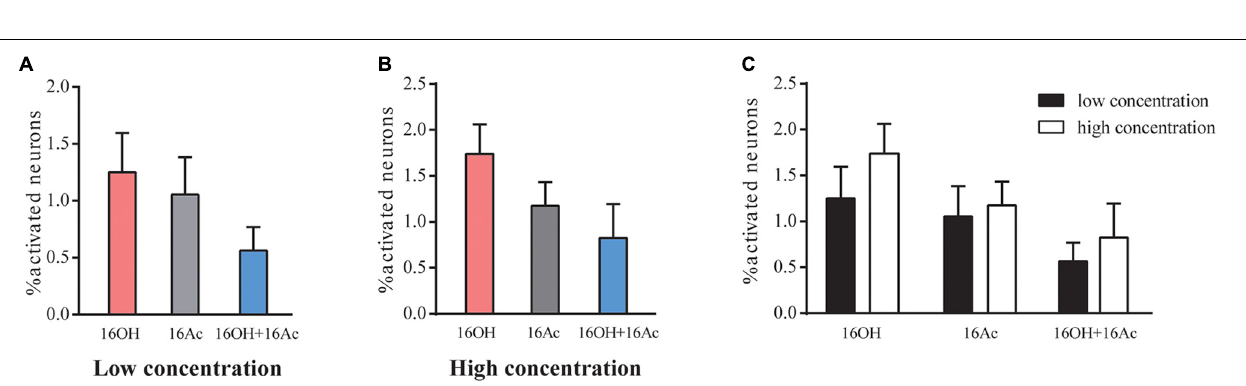
FIGURE 2 | Male VSNs respond similarly to 16OH and 16OHAc at both low and high concentrations. (A) Comparison of the percentages of male VSNs responsive to 16OH and 16Ac at a low concentration (10 nM). Out of 1175 cells examined, 14 responded to 16OH, 11 to 16Ac, 7 to both 16OH and 16Ac; and no statistically significant difference was found among them (M-L-16OH vs. M-L-16Ac, t = 0.383, p = 1.000; M-L-16OH vs. M-L-16OH+M-L-16Ac, t = 1.338, p = 1.000; M-L-16Ac vs. M-L-16OH+M-L-16Ac, t = 0.956, p = 1.000). (B) Comparison of the percentages of male VSNs responsive to 16OH and 16Ac at a high concentration (100 µ M). Out of 988 cells examined, 17 responded to 16OH, 11 to 16Ac, 8 to both 16OH and 16Ac; and no statistically significant difference was found among them (M-H-16OH vs. M-H-16Ac, t = 1.1, p = 1.000; M-H-16OH vs. M-H-16OH+M-H-16Ac, t = 1.784, p = 1.000; M-H-16Ac vs. M-H-16OH+M-H-16Ac, t = 0.683, p = 1.000). (C) Comparison analysis of the male VSNs responsive to the low and high concentrations of the pheromones. No significant difference was found between the responses to the low and high concentrations of the same pheromones in male mice (M-H-16OH vs. M-L-16OH, t = 0.953, p = 1.000; M-H-16Ac vs. M-L-16Ac, t = 0.236, p = 1.000; M-H-16OH+M-H-16Ac vs. M-L-16OH+M-L-16Ac, t = 0.508, p = 1.000). All values are expressed as mean ± s.e.m.